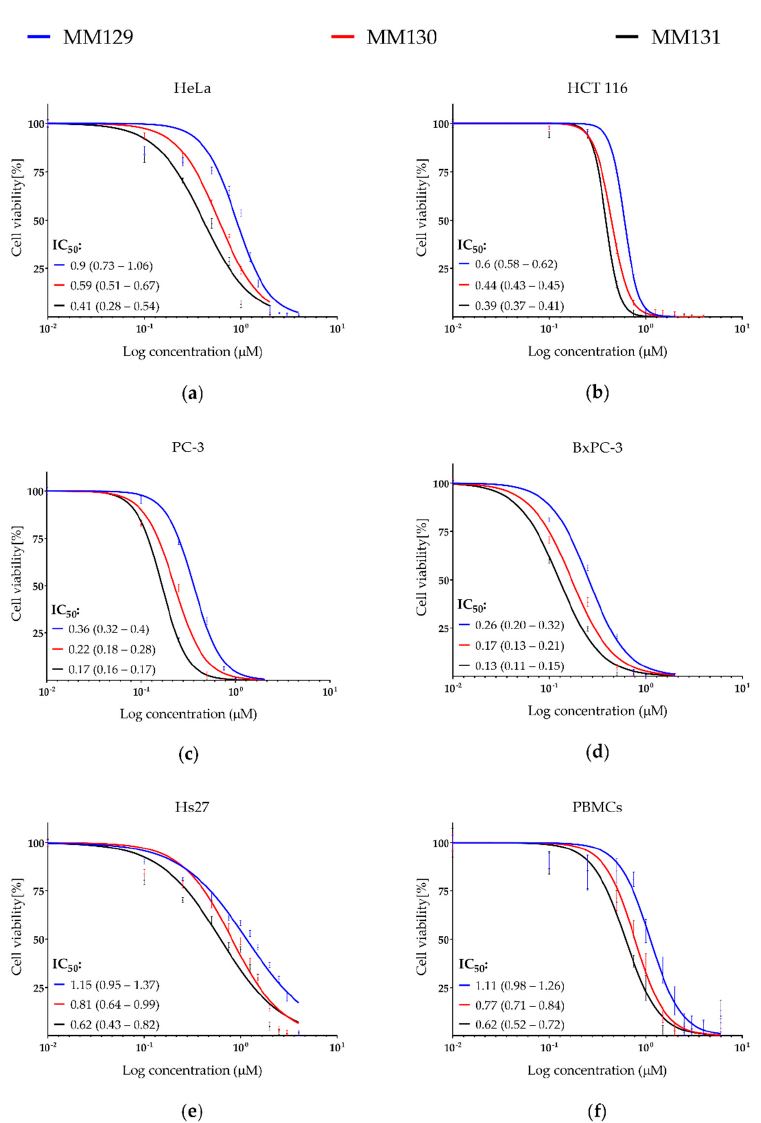
Figure 1. Evaluation of cell viability (%) of cancer cell lines: ( a ) HeLa; ( b ) HCT 116; ( c ) PC-3; ( d ) BxPC-3 and normal cells: ( e ) Hs27 and ( f ) PBMCs treated with MM129 , MM130, and MM131 . The survival curves ± SEM were presented for each tested compound. IC 50 values and 95% confidence intervals (parentheses) are given in μ M.